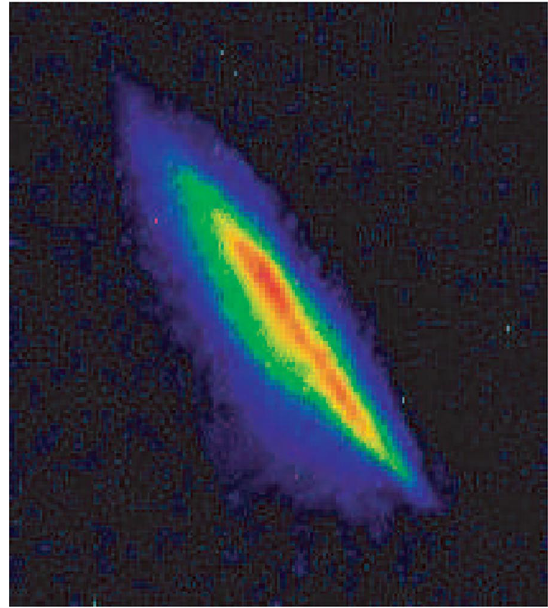
FIG. 26. (Color) Measured horizontal and vertical normalized emittances of the 300 fs beam versus the compressor solenoid